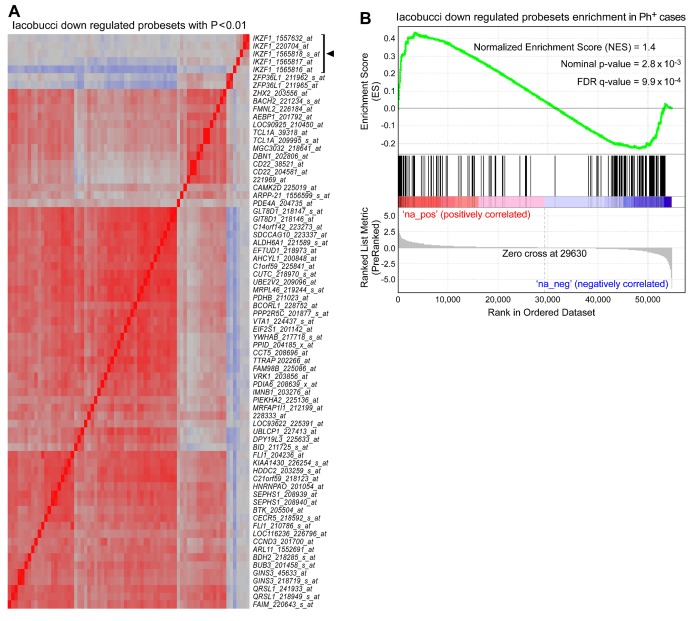
Gene Expression Signature for Adult IKZF1 Deletions Reported for Adult Ph+ BPL is not Found in Pediatric Ph+ BPL.[A] Correlation cluster forms distinct modules for expression of exon specific probe sets for IKZF1 and significantly down regulated probe sets for adult IKZF1 deletions in primary leukemic cells from pediatric BPL patients. Probeset correlations were clustered for the most significant down regulated probe sets in the Iacobucci study (P<0.01) and IKZF1 probesets specific for Exons 1-4 in pediatric leukemic samples. [B] Rank ordered difference in log2 transformed RMA expression values between primary leukemic bone marrow specimens from Ph+ BPL patients (N=123) and normal bone marrow specimens (N=74) were processed for enrichment of 158 Iacobucci down regulated probe sets using a supervised approach implemented in GSEA2.08 (Broad institute). Significance was assessed using weighted Kolmogorov-Smirnov statistics. Contrary to expectation, the gene signature for probe sets down regulated in IKZF1 deleted adult Ph+ BPL specimens were significantly over-represented in probe sets up regulated in Ph+ pediatric BPL cases (P-value = 2.8 x 10-3; hits shown by black lines on the graph and the heat map depicting blue color to indicate down regulation and red color to indicate up regulation of probesets in Ph+ BPL cases versus Normal).